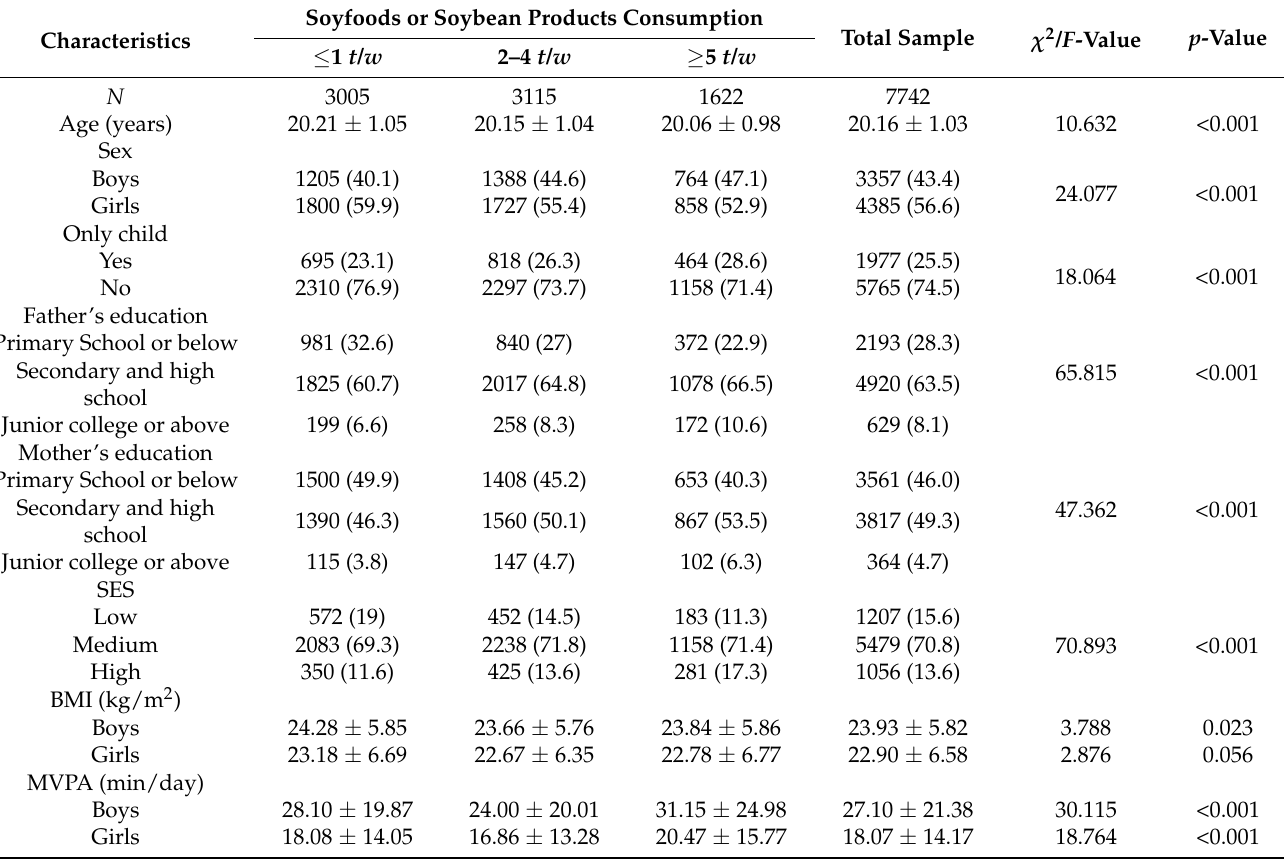
Table 1. Comparison of the consumption status of soy food or soy products among college students with different characteristics in